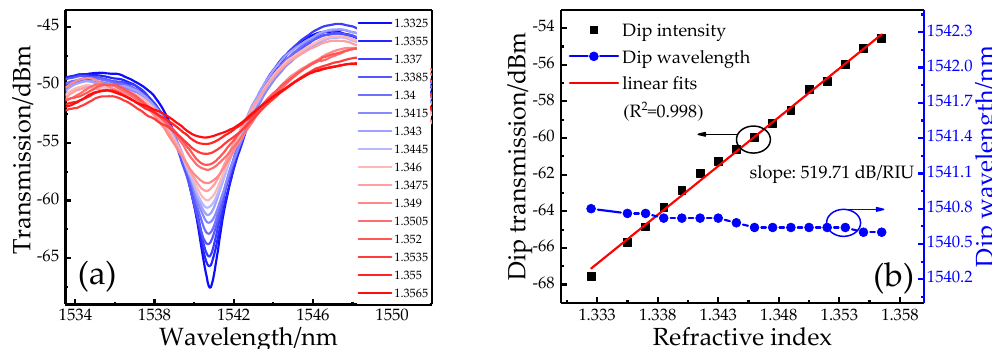
Figure 4. ( a ) Transmission spectra of SP structure and ( b ) the wavelength and intensity responses with a varied surrounding refractive index (SRI).